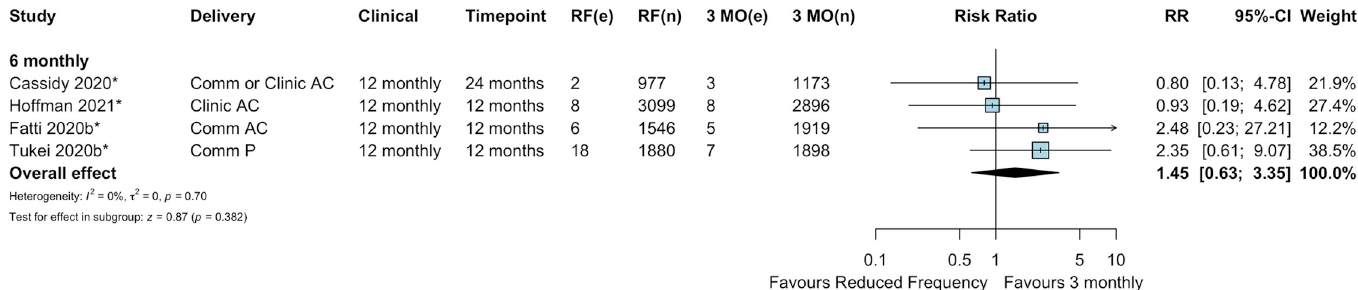
PLOS Medicine| https://doi.org/10.1371/journal.pmed.1003959 March 22,